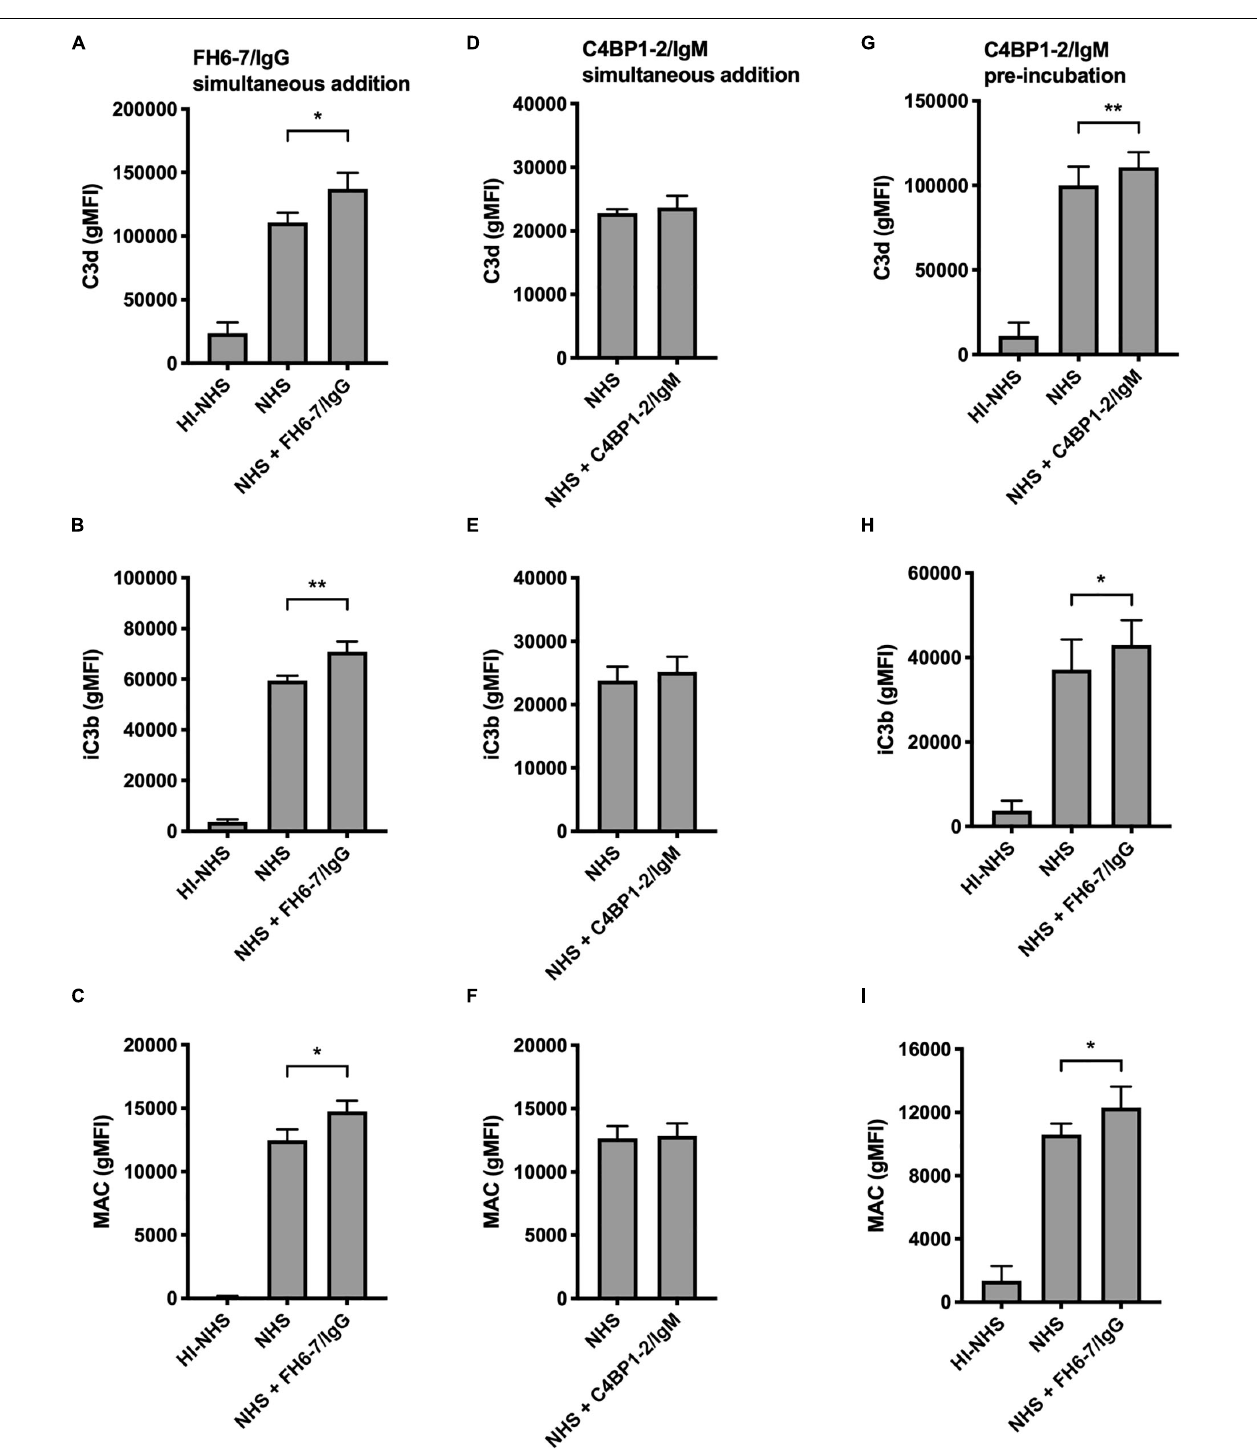
FIGURE 5 | Fusion proteins increase complement deposition on the bacterial surface. Flow cytometry was used to measure C3d, iC3b, and MAC binding at the surface of M. catarrhalis . (A–C) FH6-7/IgG and serum were added simultaneously to bacteria. Bacteria were incubated with 5% OmCI-treated serum for 30 min for C3 deposition, or 10% NHS for 20 min for MAC deposition. Heat-inactivated serum was used as a negative control of complement activation. (D–F) C4BP1-2/IgM and serum were added simultaneously to bacteria. (G–I) Bacteria were pre-incubated with C4BP1-2/IgM before addition of serum. Mean ( ± SD) from three (A–F) or four (G–I) independent experiments are shown. Statistical significance of differences was calculated using one-way ANOVA with Dunnett’s post-test; * p < 0.05; ** p < 0.01.